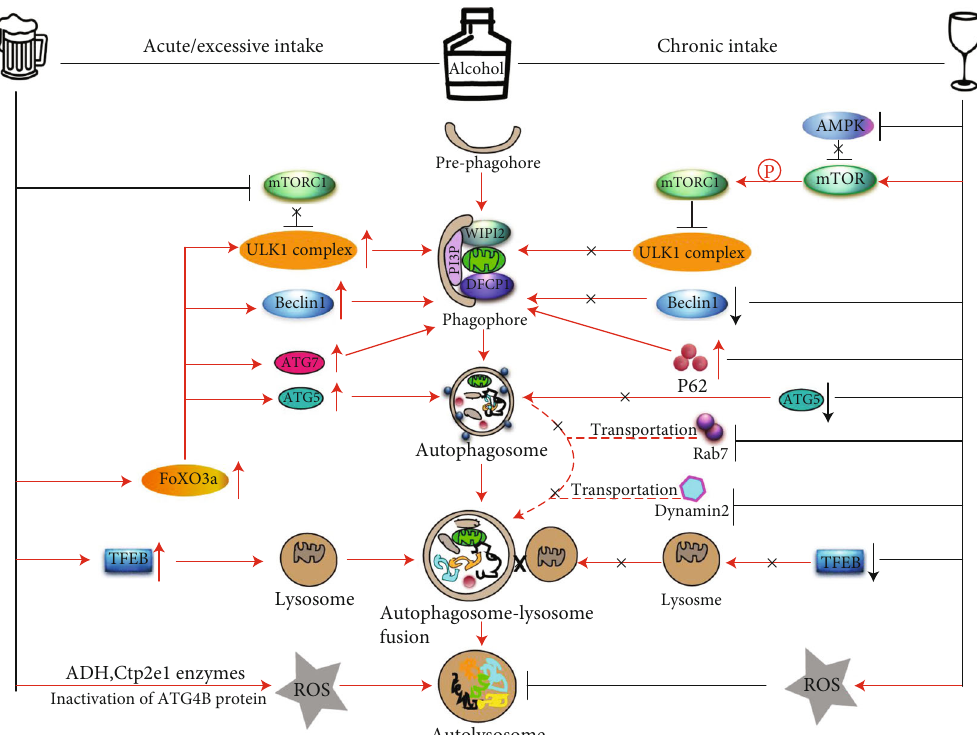
Figure 3: Schematic model represents the molecular role of acute and chronic intake of alcohol in the induction of autophagy/impaired autophagy in AFLD. Acute ethanol induces ADH- and CYP2E1-mediated ROS production that inactivates ATG4B protein and induces autophagy. Acute consumption of alcohol inhibits AKT and mTORC1 complex and increases FoxO3a- and TFEB-mediated expression of ATG5, ATG7, Beclin 1, and ULK1 proteins upregulating autophagosomal-lysosomal fusion and functional autophagy. In contrast, chronic intake/consumption of alcohol inactivates AMPK but activates the mTORC1 complex which in turn inactivates the ULK1 complex and inhibits phagophore formation. Moreover, chronic consumption of alcohol downregulates the nuclear localization of TFEB, reduces expression of Beclin-1, and ATG5 that inhibits the phagophore to autophagosome transition. Chronic alcohol also inhibits Dynamin 2, disturbs the transportation of Rab7 into the lysosomal membrane, and impairs autophagosomal-lysosomal